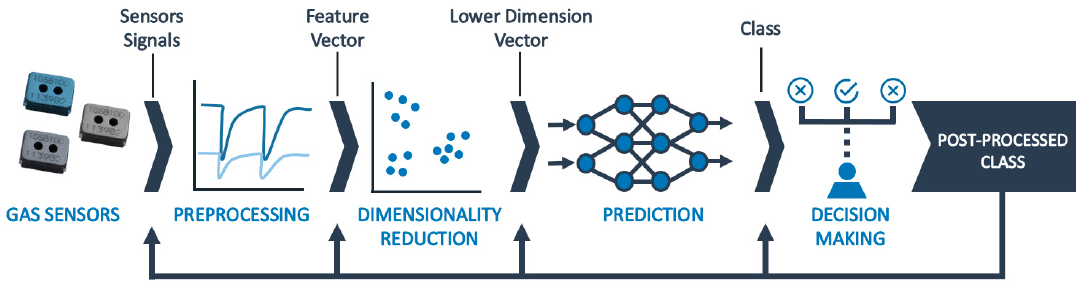
Figure 9. Data processing block diagram.